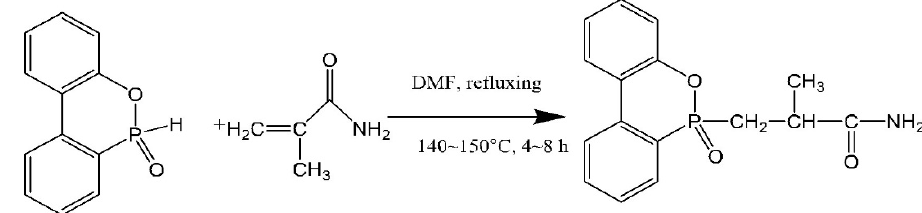
Figure 1. Synthetic route of DOPO-MAC.